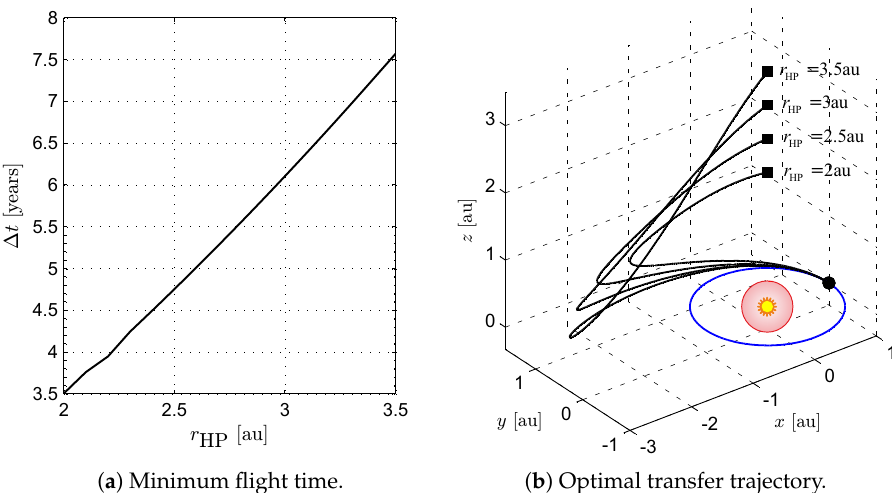
Figure 11. The minimum flight time and optimal transfer trajectory to reach a polar HP as a function of the solar